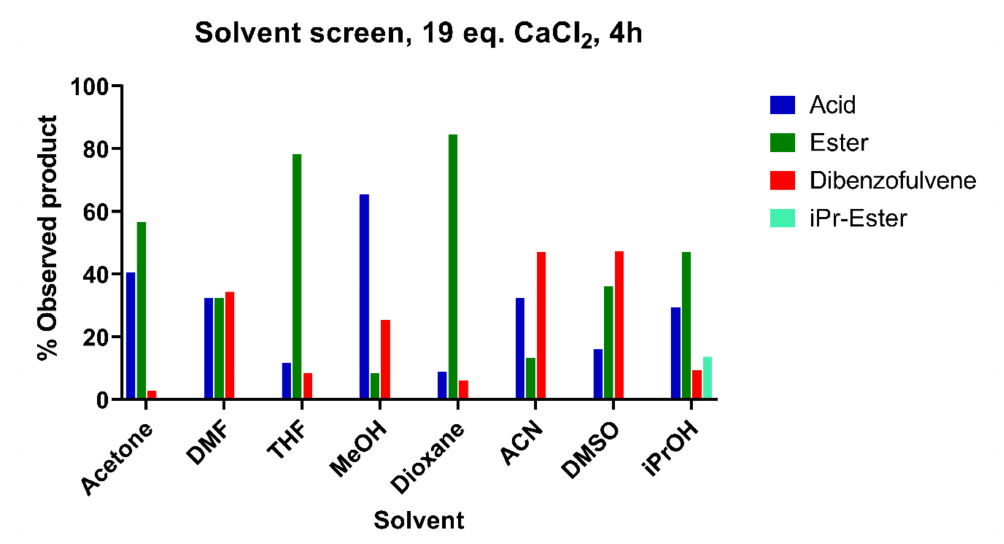
Figure 1. Screening of the organic solvent at RT for 4 h in standard conditions using 1.5 eq. of NaOH and 19 eq. of CaCl 2